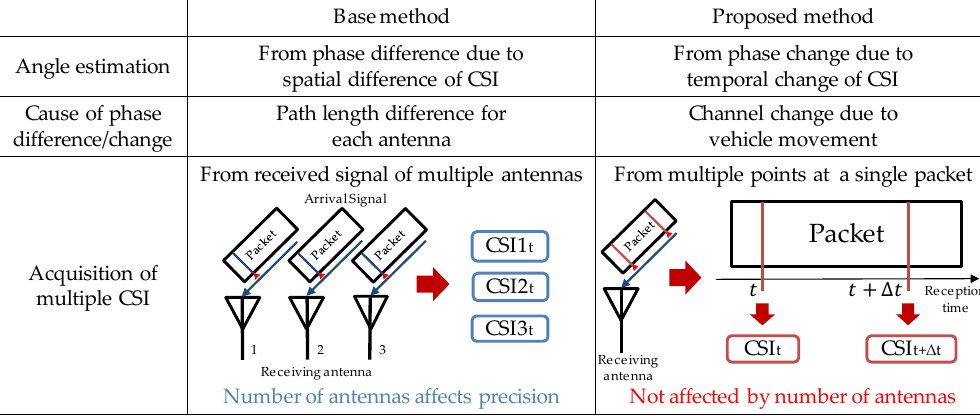
Figure 6. Comparison between the base method [11] and the proposed method.